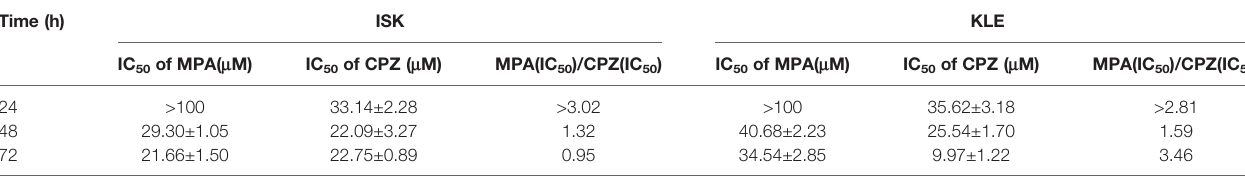
Results are expressed as the mean of at least three replicates.